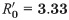
The reproduction number of the original strain is R0 = 0.8, while the reproduction number of the emergent strain is R0′=3.33.This scenario corresponds to the emergence of the new strain under DFE conditions. The vaccination rate used is 0.5.